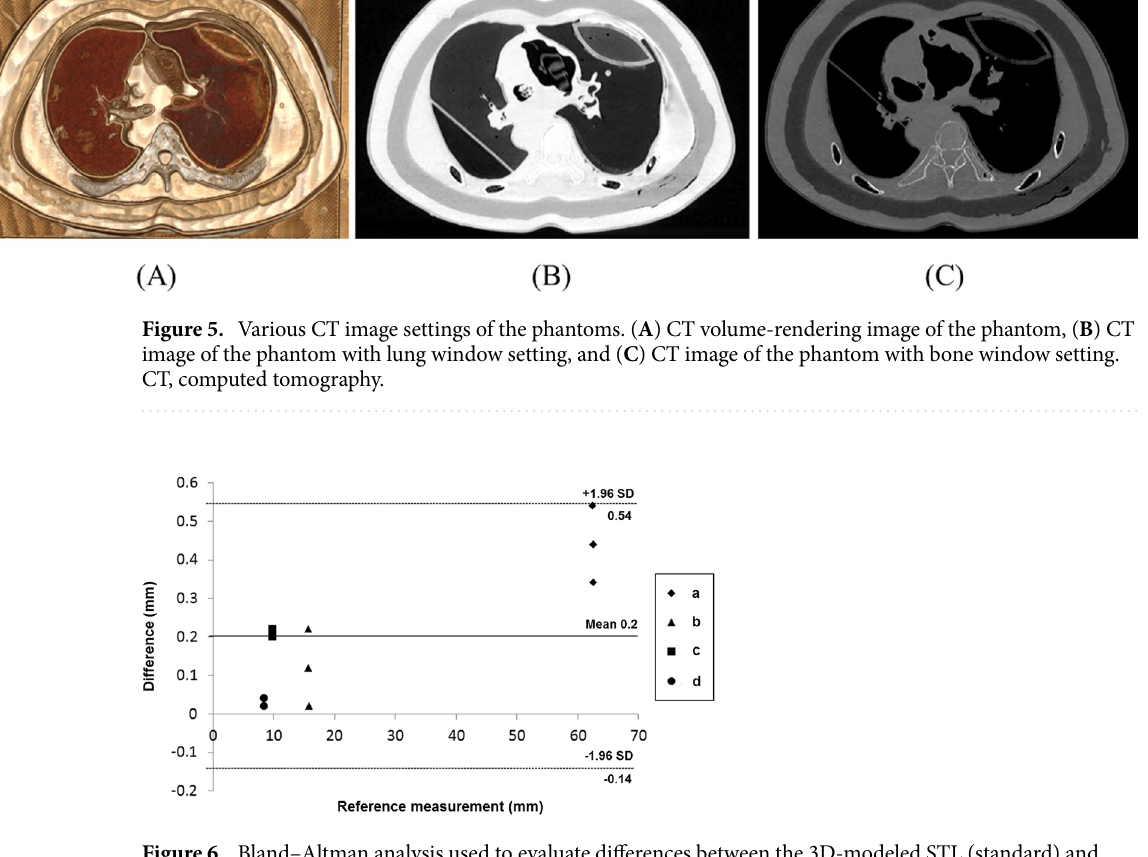
Figure 6. Bland–Altman analysis used to evaluate differences between the 3D-modeled STL (standard) and the CT from the printed phantom. ( a ) Inner diameter of the right ventricle, ( b ) solid nodule, ( c ) part of a lung vessel, and ( d ) part of the airway. CT, computed tomography; 3D,